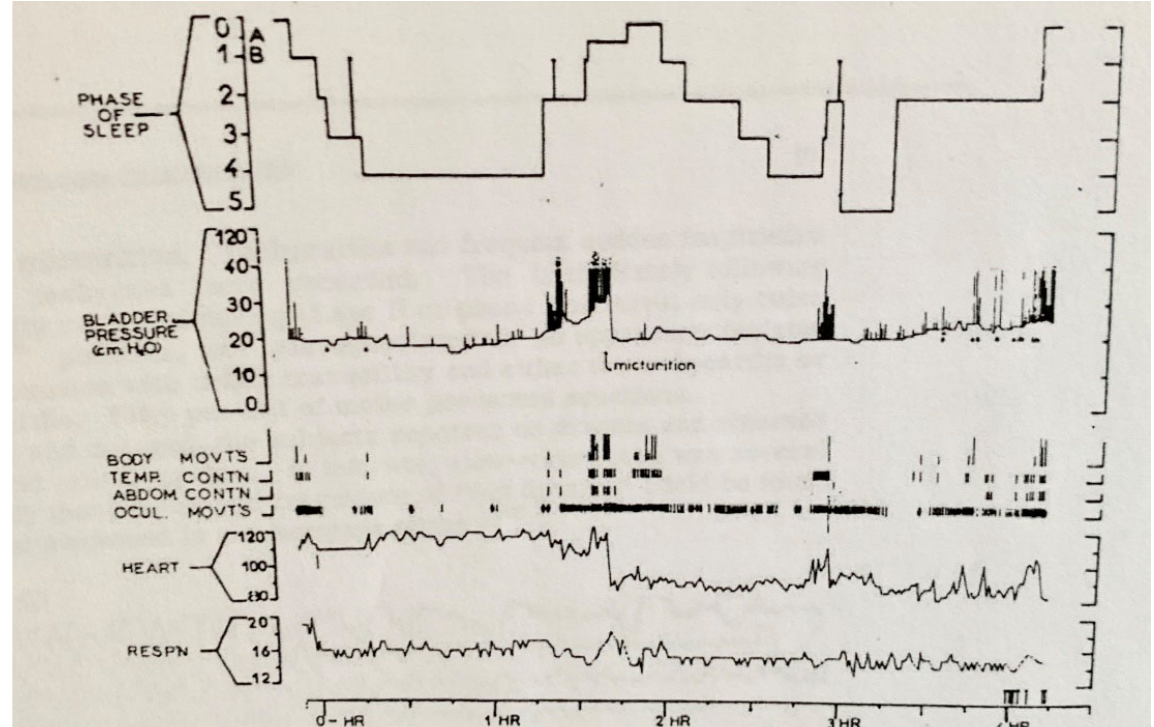
Figure 5. Histogram of an enuretic episode with intra-vesicular recording of bladder pressure. Sleep stage 5 is REM sleep. Before the micturition around the end of stage 4 there is an increase in the baseline bladder pressure with superimposed increases reaching 80 cm water pressure. When enuresis takes place there is a precipitous drop in bladder pressure followed by an absence of further contractions for about an hour. The high heart rate before enuresis drops abruptly when enuresis occurs. There is a similar but less dramatic decrease in respiratory rate when enuresis takes place (Adapted from Gastaut, H. and Broughton, R.: A clinical and polygraphic study of